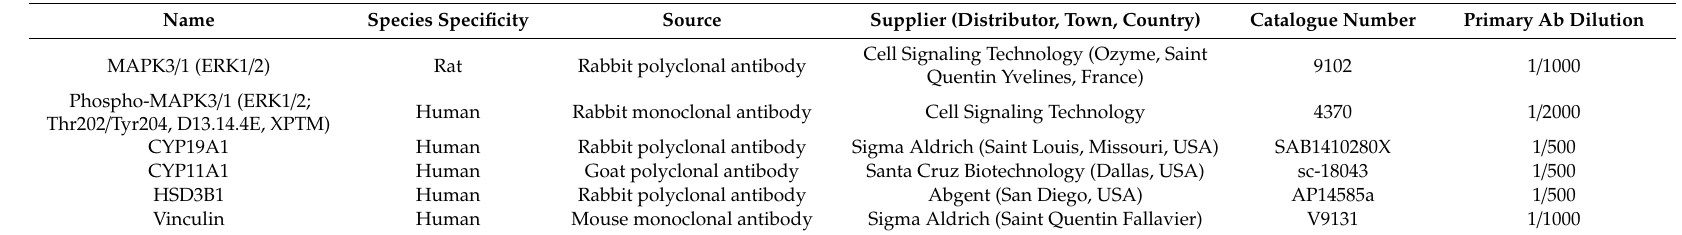
Table 2. Characteristics of primary antibodies used for western